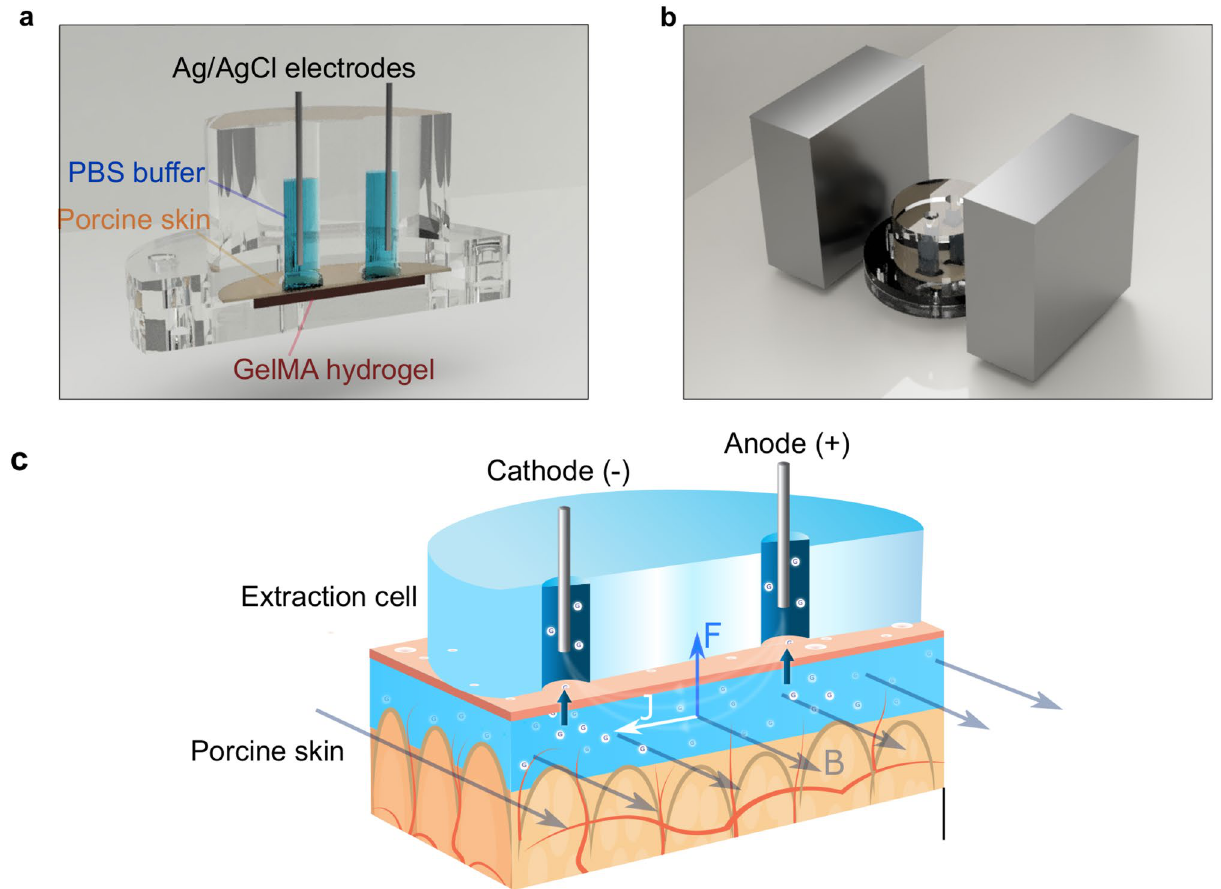
Figure 1. ( a ) 3D model construction of MHD with the extraction cell cut out to reveal the main parts of the cell: GelMA hydrogel at the bottom, porcine skin on top of the hydrogel, electrode wells filled with buffer (PBS, 10 mM, pH 7.4) and Ag/AgCl electrodes (ø = 1 mm, length = 2.5 cm). ( b ) The extraction chamber is positioned between two neodymium magnets (size: 70 mm × 70 mm × 30 mm). ( c ) Schematic picture of glucose extraction using MHD. An electric current is established between the two electrode chambers filled with buffer solution. The electric current induces electro-osmotic flow from the anode through the skin towards the cathode. A current density profile (J) in the presence of a magnetic field (B) generates a Lorentz force (F) that drives the interstitial fluid towards the skin magnetic field. At constant electric energy deposition and constant electrode contact area, the distribution of the current density in the skin does not significantly affect the extraction efficiency according to the literature of reverse iontophoresis 45,49 . For MHD, the distribution of the current density in the skin determines the distribu- tion of the Lorentz force according to F = J × B . This may allow maximizing the energy efficiency of the extrac- tion by optimizing the electrode morphology and the distribution of the magnetic field. Since the magnetic field was measured inside the empty cathodic electrode well, the exact distribution of the magnetic field across the GelMA hydrogel and the skin was unknown. However, the extraction cell was positioned at the center and in between the magnets, where the magnetic field is substantially homogenous. Furthermore, skin, water, air, and the materials of the set up (i.e. PMMA/Acrylic) feature similar relative magnetic permeabilities ( μ r ≈ 1). Hence, little distortion of the magnetic field induced by the different materials was expected. During each extraction, we monitored the voltage between the extraction electrodes to investigate potential discrepancies in electric impedance in the skin samples. Figure 2c shows the measured voltage responses for reverse iontophoresis and MHD with different magnetic fields. For each condition, the voltage stayed relatively constant and the average voltage for each extraction was 0.24 V (Fig. S3). After each experiment, we counted the number of hair follicles inside the area of the electrode well (Fig. 2d) to investigate potential correlation between the number of hair follicles and the amount of extracted glucose. The number of hair follicles was between 5 and 26. However, most skin samples featured 5 to 15 hair follicles. Even though the spread in the number of hair follicles per well area was relatively large, we observed no obvious correlation between the number of hair follicles and extracted glucose (Fig. 2e). Furthermore, we studied whether small differences in skin thickness affect the extraction (Fig. 2f). We chose skin thicknesses between 600 and 700 µm and observed no trends in the amount of glucose extracted with increasing skin thickness. However, the amount of glucose extracted dur- ing 10 min depended on the glucose concentration in the GelMA hydrogel (Fig. 2g). This finding indicates that